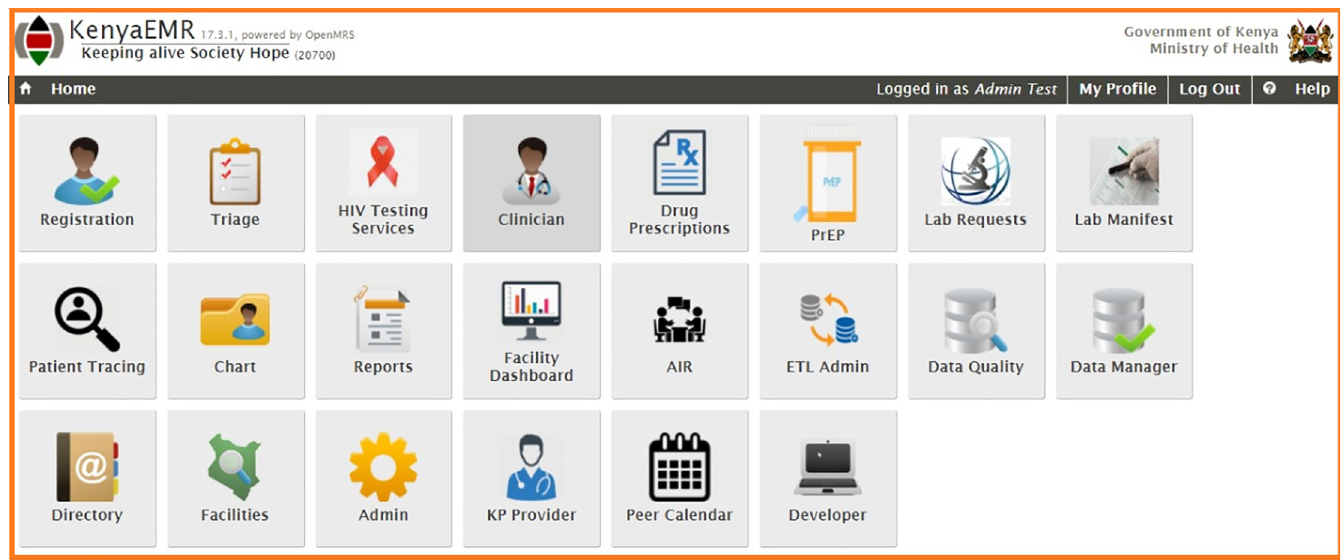
Fig 1. Screenshot of KeEMRs home page. Reprinted from [33] under a CC BY license, with permission from The Palladium Group- KeHMIS II Project, original copyright 2012.